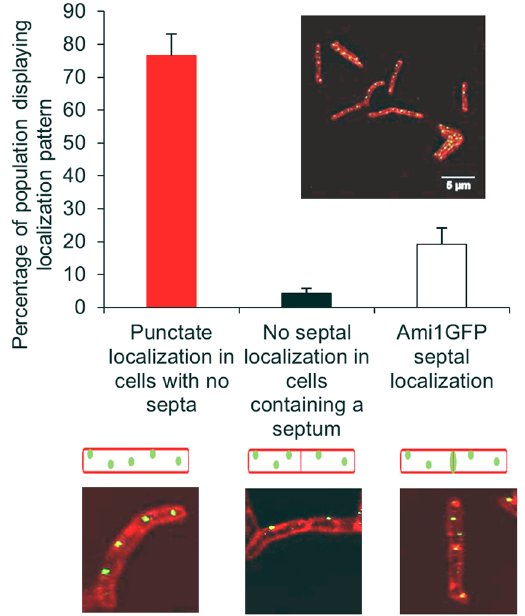
Figure 9. Cellular localization of Ami1-rsEGFP in M. smegmatis . Depicted are the three observed localization patterns which include, punctate localization along the lateral axis of the cells with no septa, no septal Ami1 localization in cells containing a septum and septal localization. The histogram depicts the proportion of cells which display the three observed localization patterns. The insert shows a representative view of cells. A total of 589 cells were assessed for